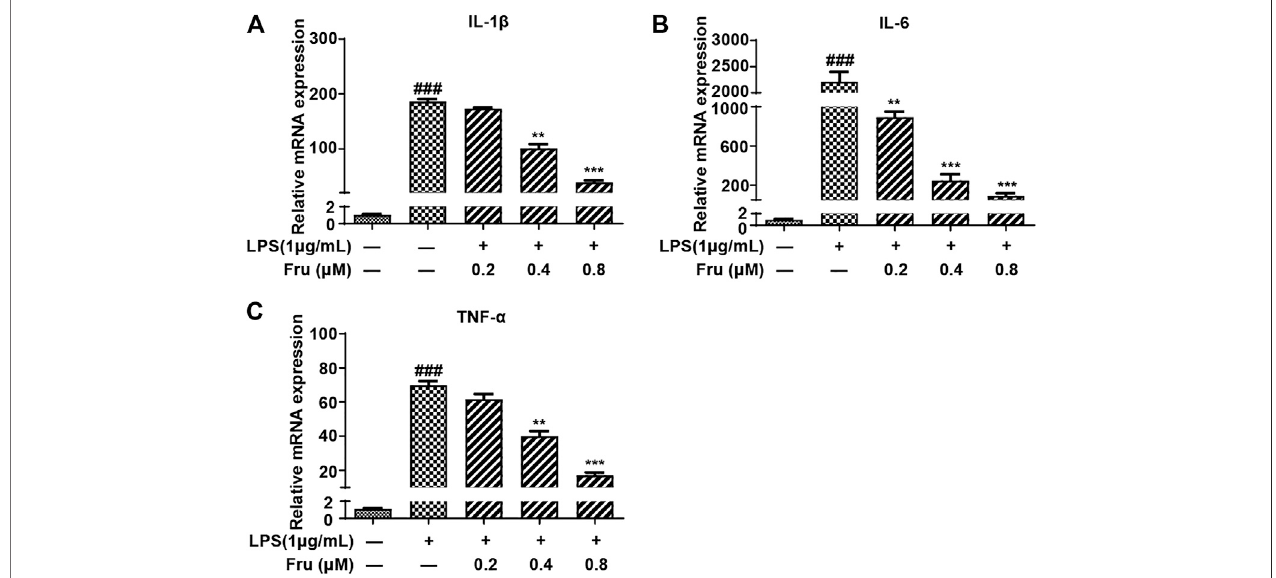
FIGURE 2 | Fru suppressed mRNA expression of proin fl ammatory cytokines in LPS-induced RAW264.7 cells. Cells were treated with different concentrations of Fru(0.2,0.4,and0.8 μ M)for2 handthenstimulatedwithorwithoutLPS(1 μ g/ml)for18 h.TherelativemRNAexpressionlevelsofIL-1 β (Panel (A) ),IL-6(Panel (B) ),and TNF- α (Panel (C) ) were measured with qRT-PCR and normalized to GAPDH. Quantitative data was represented as mean ± SD ( n (cid:2) 3, ### p < 0.001 vs. Control; ** p < 0.01, *** p < 0.001 vs. LPS).